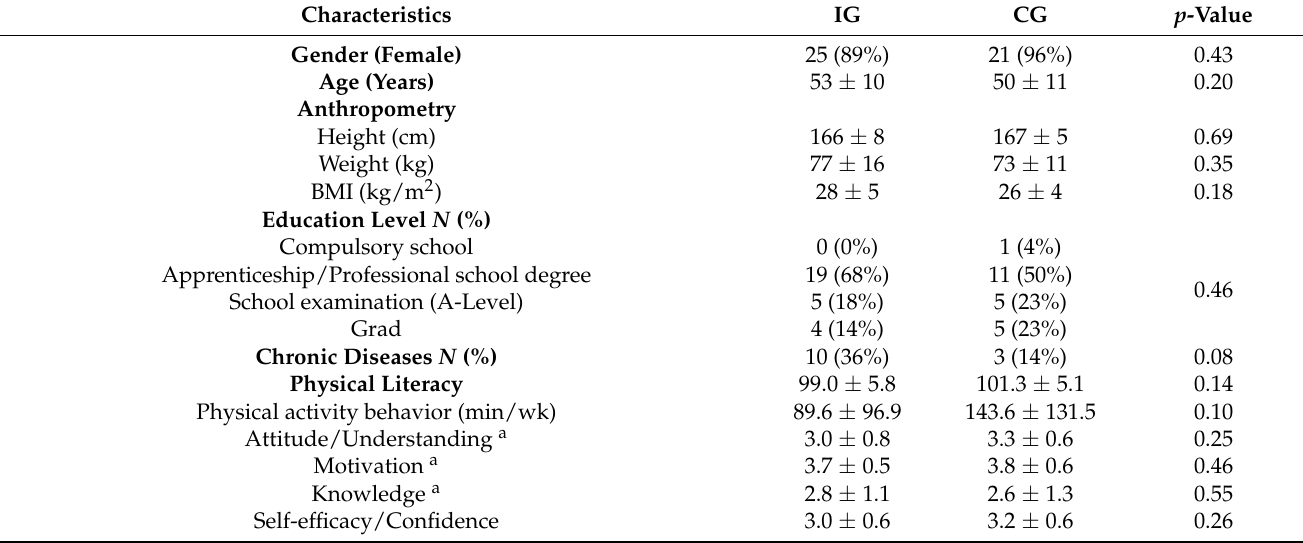
Table 1. Participant characteristics at